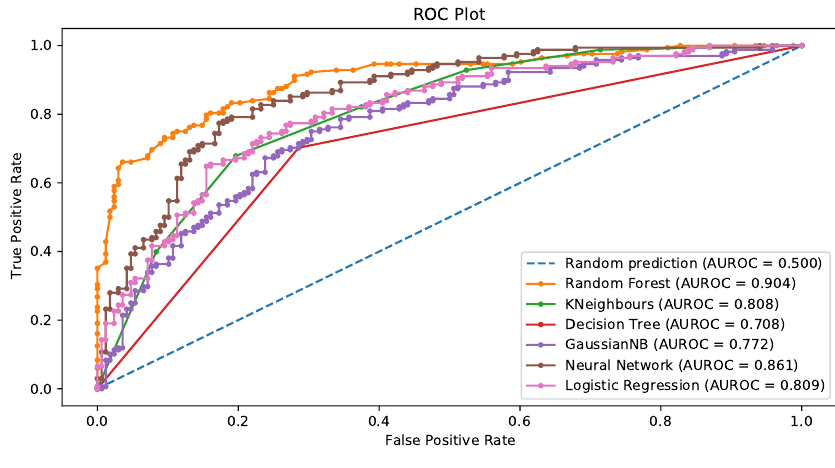
Figure 9. SMOTEtomek.